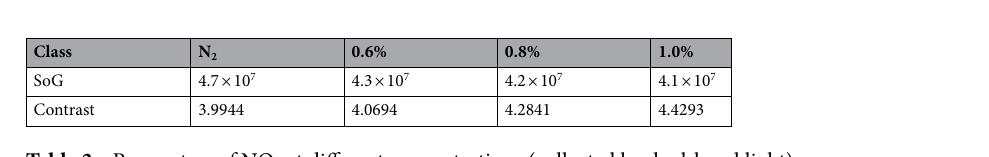
Table 3. Parameters of NO 2 at different concentrations (collected by dual-band